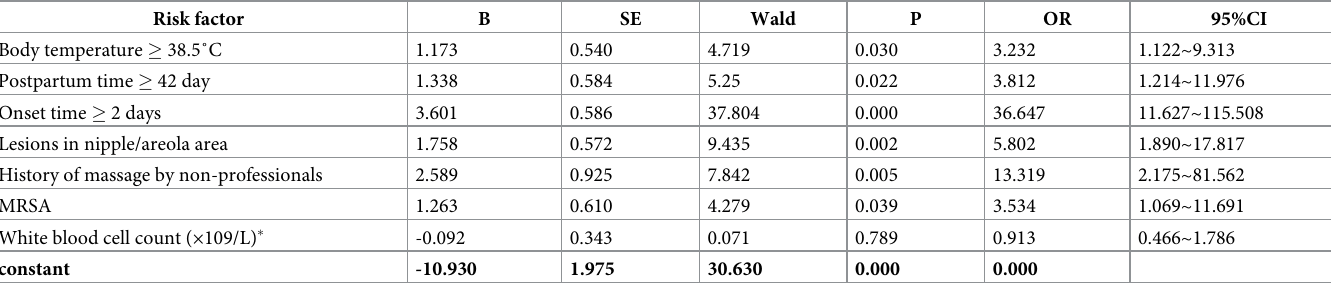
Table 4. Multivariate analysis of progression from acute mastitis to mammary